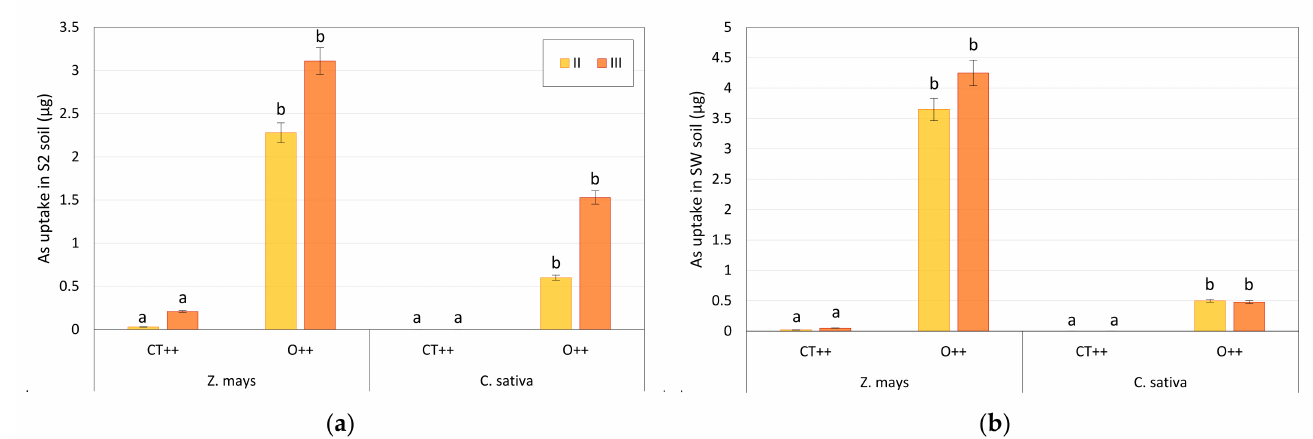
Figure 10. Arsenic total uptake comparison in shoots of Z. mays and C. sativa grown on soil control (CT) and As-contaminated soil samples treated with oxalate (O): ( a ) S2 soil, ( b ) SW soil. PGPR bacteria (second set of isolates) were added to all soil samples, as indicated by the “++” sign. The values are the mean of three replicates, and the error bars show the standard deviation. Values with different letters are significantly different at the 5% probability level (Tukey’s